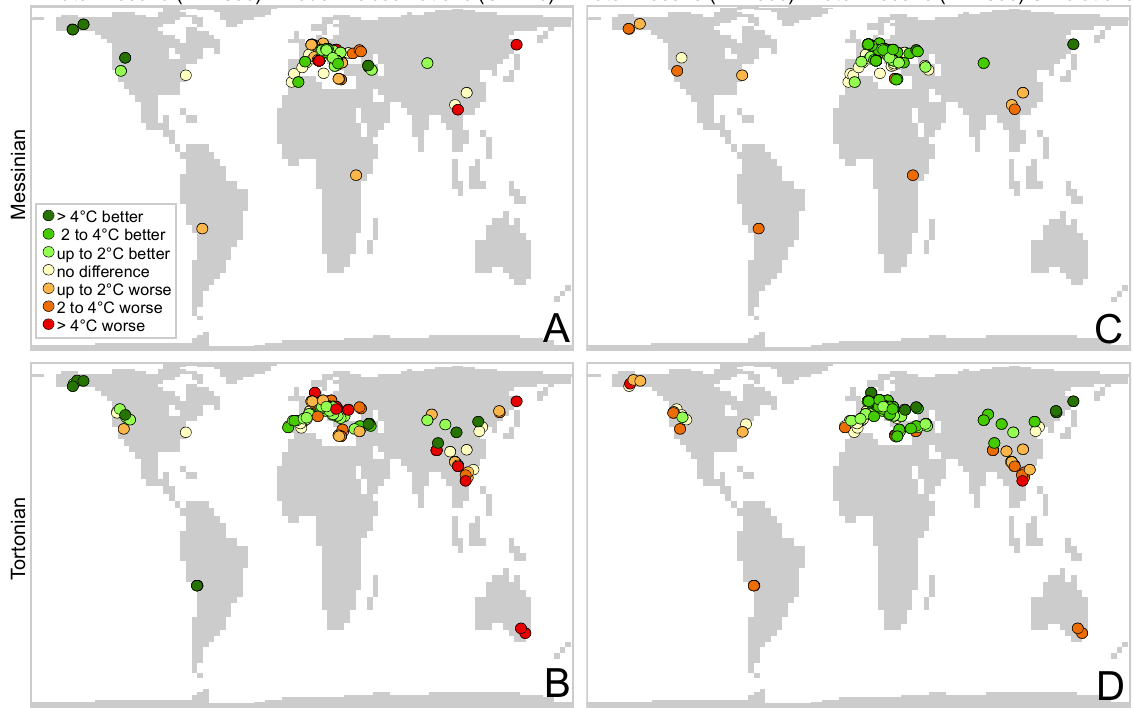
Fig. 10. Improvements in the model–data comparison for mean annual temperature. The lefthand column (A, B) shows the improvement that the late Miocene palaeogeography makes to the model–data comparison. The righthand column (C, D) shows the improvement that higher CO 2 makes to the model–data comparison. Green circles indicate an improvement; red circles indicate a deterioration. The datapoints showing “no difference” are plotted underneath the other datapoints in order to highlight the differences.